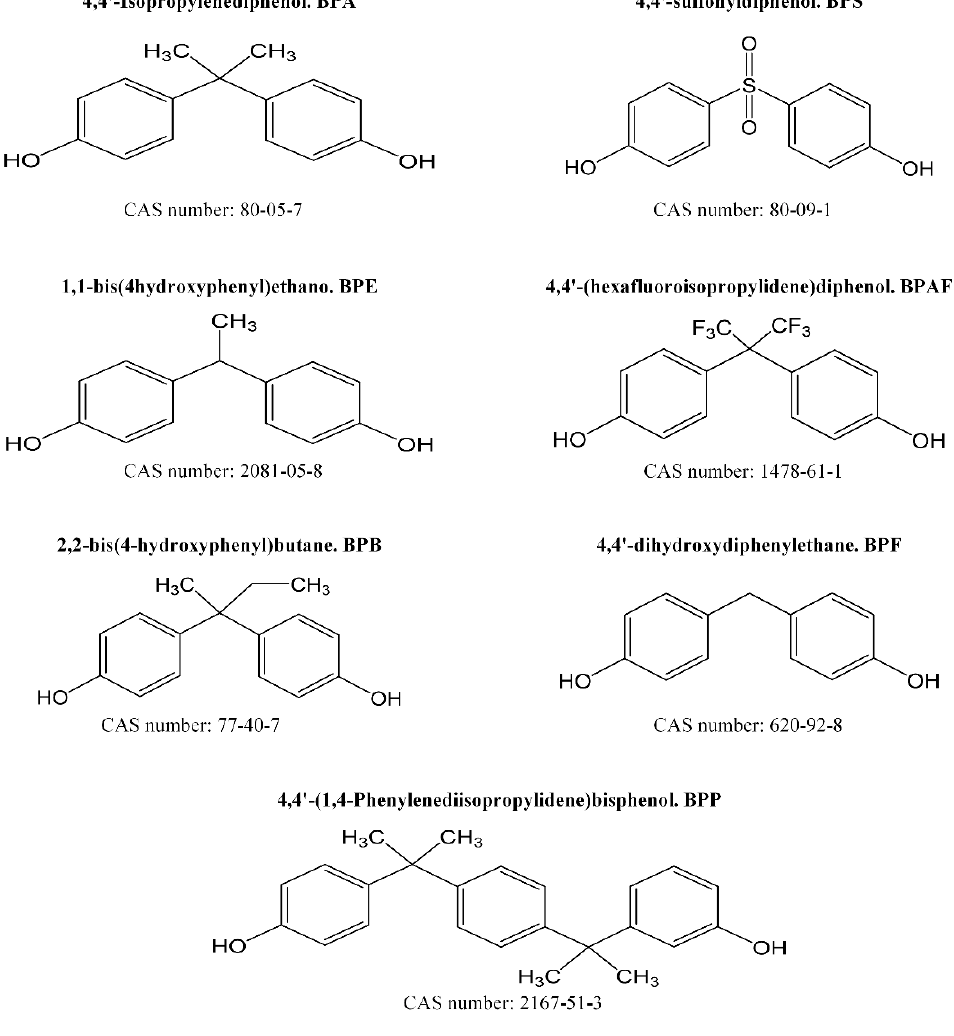
Figure 2. Bisphenols analysed in the present